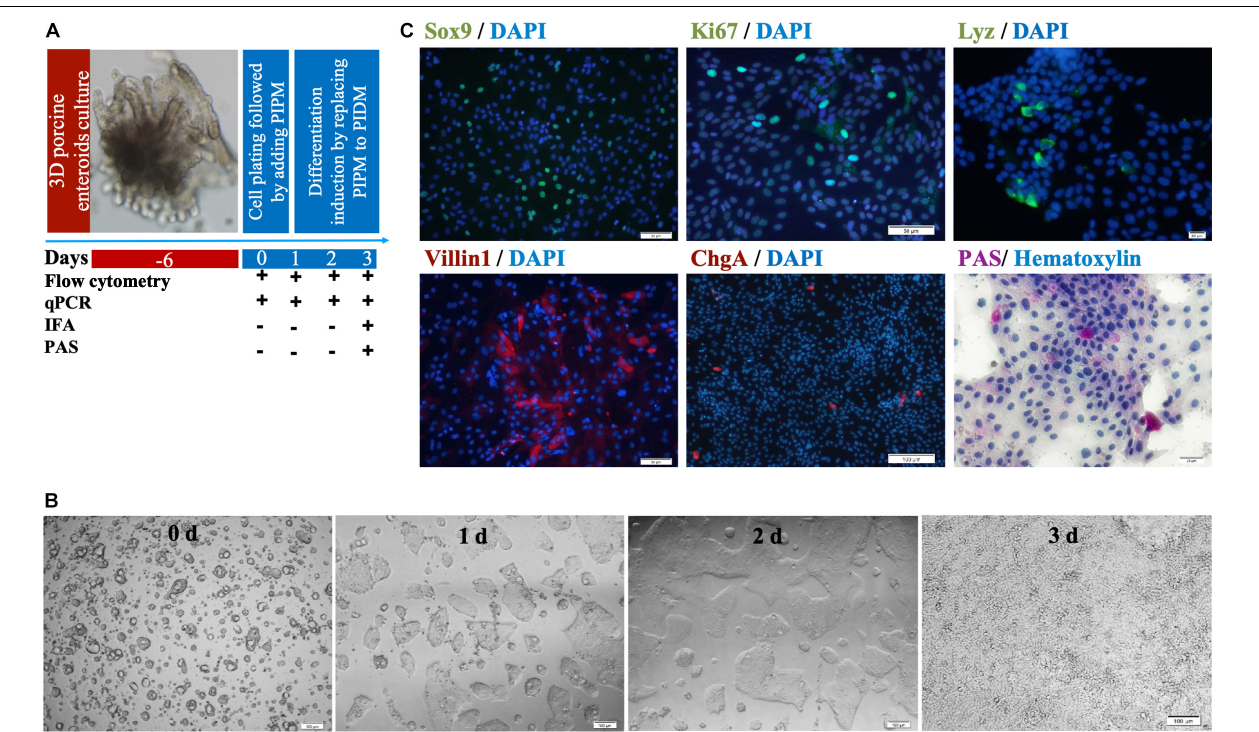
FIGURE 3 | Identification of cell subsets in differentiating MPIEs. (A) The schedule of sample collection of the differentiating two-dimensional porcine enteroids. (B) Representative images of monolayer enteroids at different time points (Scale bar = 100 µ m). (C) Identification of cell subsets in differentiating enteroids. Transcription factors Sox9 expressed in CBC stem cells (green) (Scale bar = 50 µ m), Ki67 protein expressed in TA proliferating cells (Scale bar = 50 µ m), Lysozyme (Lyz)-containing Paneth cells (green) (scale bar = 20 µ m), apical brush border protein Villin1 expressed in enterocytes (green) (Scale bar = 50 µ m), Chromogranin A (ChgA)-containing enteroendocrine cells (red) (Scale bar = 100 µ m) and Periodic acid-Schiff stain-reacting goblet cells (purple), nuclear